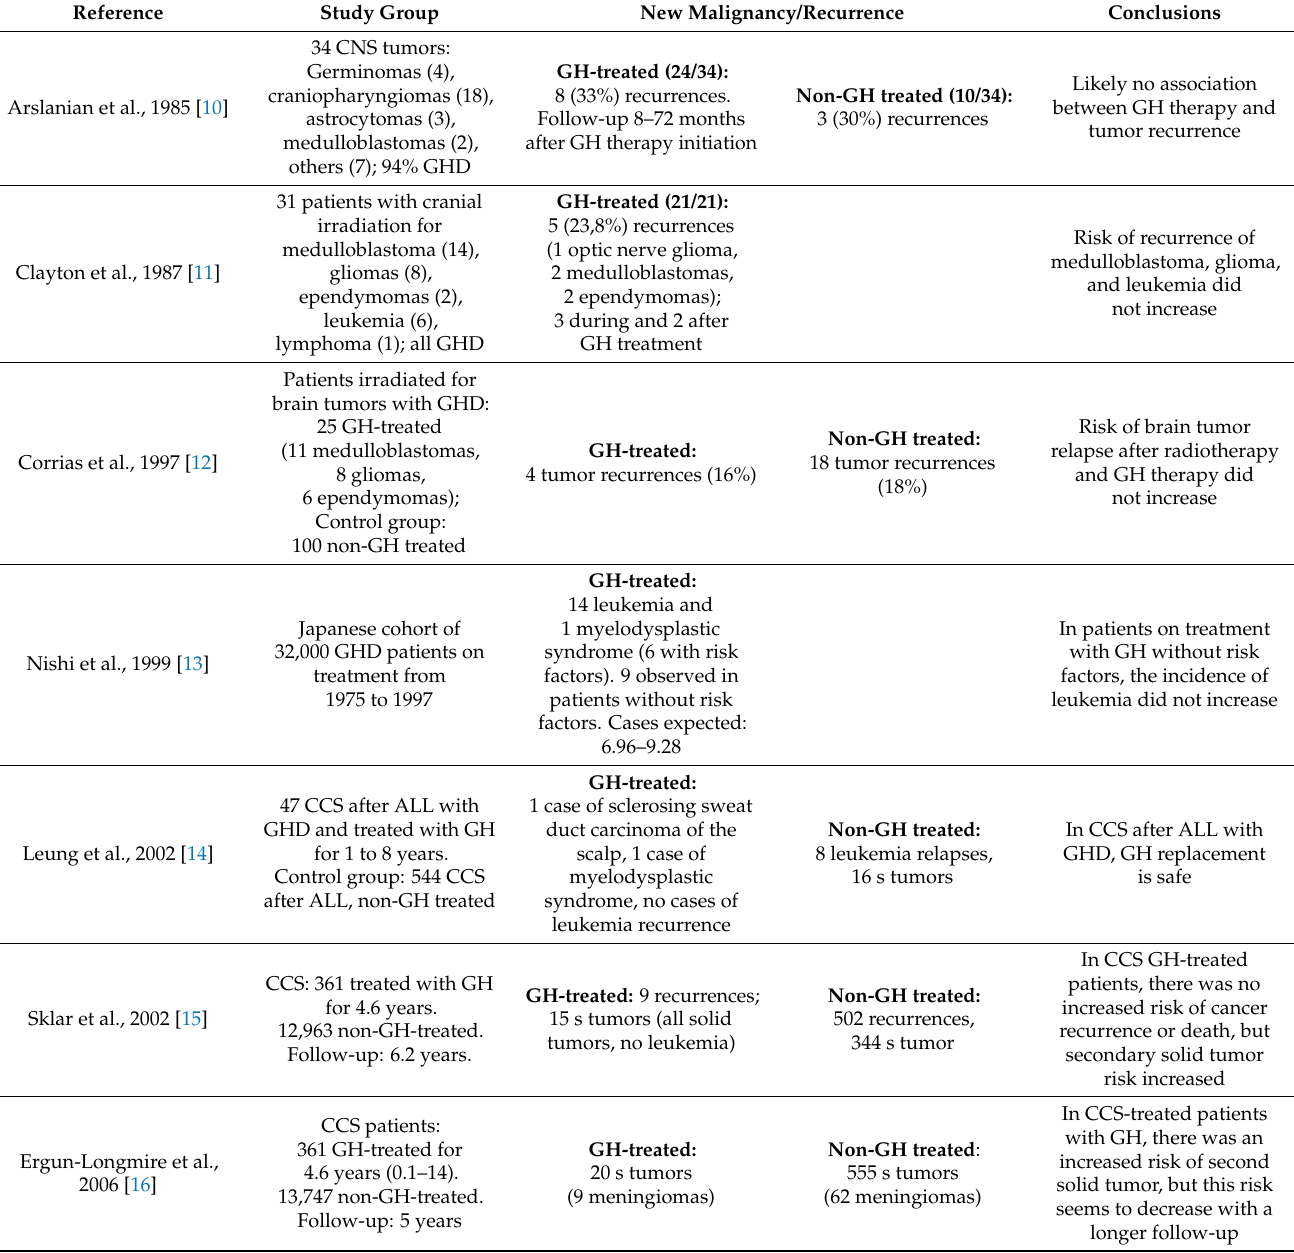
Table 1. Studies reporting data on cancer risk and GH